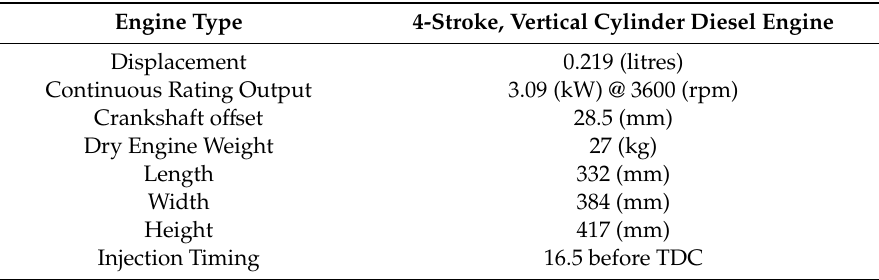
Table 2. Engine specification.